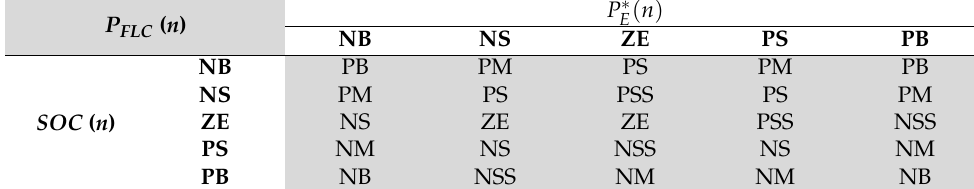
Table 1. Heuristic approach rule base energy management system (EMS) [43].